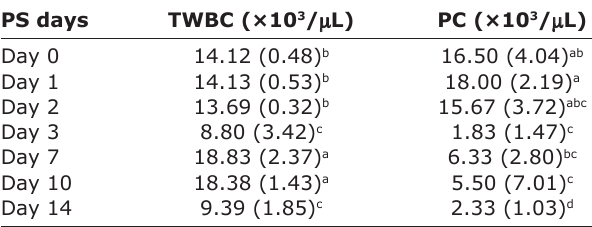
Table-2: Changes in the mean TWBC and PC of CPDA-1 SCB PS of